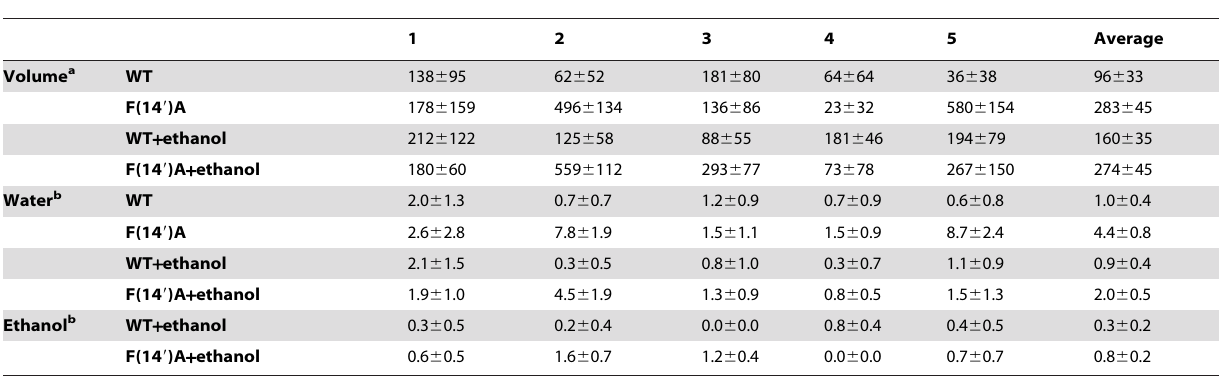
Table 2. Inter-subunit cavity properties.